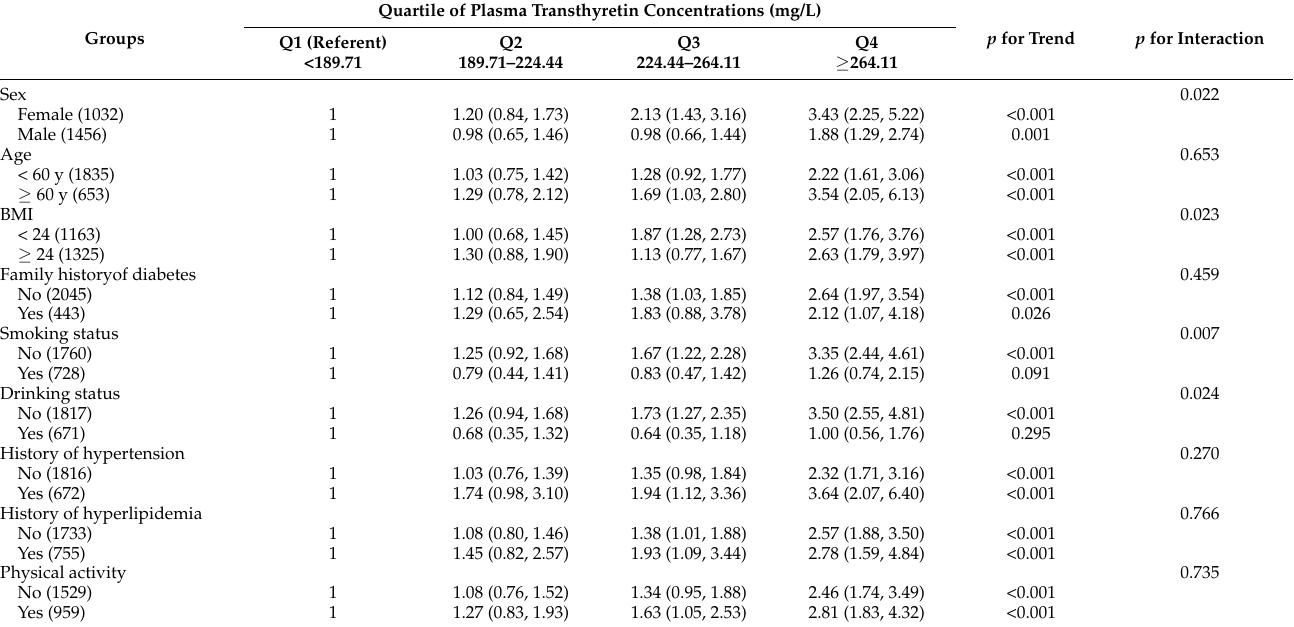
Table 3. Multiple adjusted odds ratios for plasma transthyretin levels associated with T2DM in